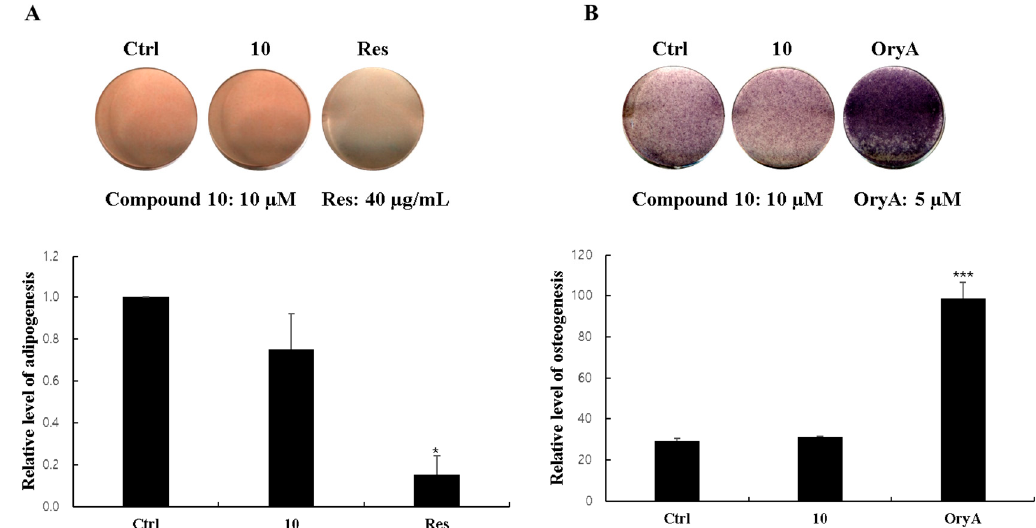
Figure 3. Reciprocal effects of compound 10 on the differentiation of MSCs into adipocytes or osteoblasts. Mouse mesenchymal stem cells (C3H10T1/2) were treated with 10 µ M compound 10 . After adipogenic differentiation, the cells were stained with Oil Red O (ORO), and the number of stained lipid droplets was quantitatively evaluated ( A ). After osteoblast differentiation, the cells were stained for ALP levels, and the ALP activity was measured ( B ). Ctrl represents untreated negative control. For the positive controls, 40 micrograms of resveratrol (Res) was used for adipogenesis and 5 µ M of oryzativol A (OryA) was added for osteogenesis. * denotes 0.01 ≤ p ≤ 0.05 and *** denotes p < 0.001.